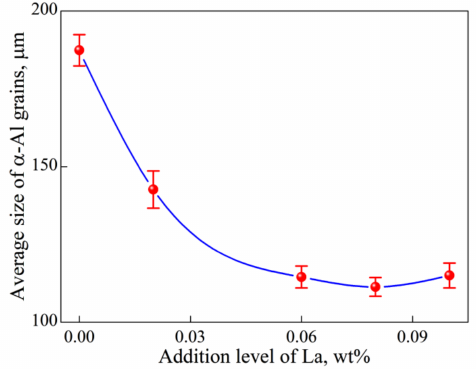
Figure 2. Average size of α -Al grains in Al-2Cu alloy by adding 0.4% Al-5Ti-1B vs. La addition level. Figure 3 shows the SEM image and EDS line-scanning results for Al-2Cu alloy inocu- lated with 0.4% Al-5Ti-1B + 0.08% La. The results demonstrate that trace La enriches at the surface of TiB 2 particles along with solutes Cu and Ti.